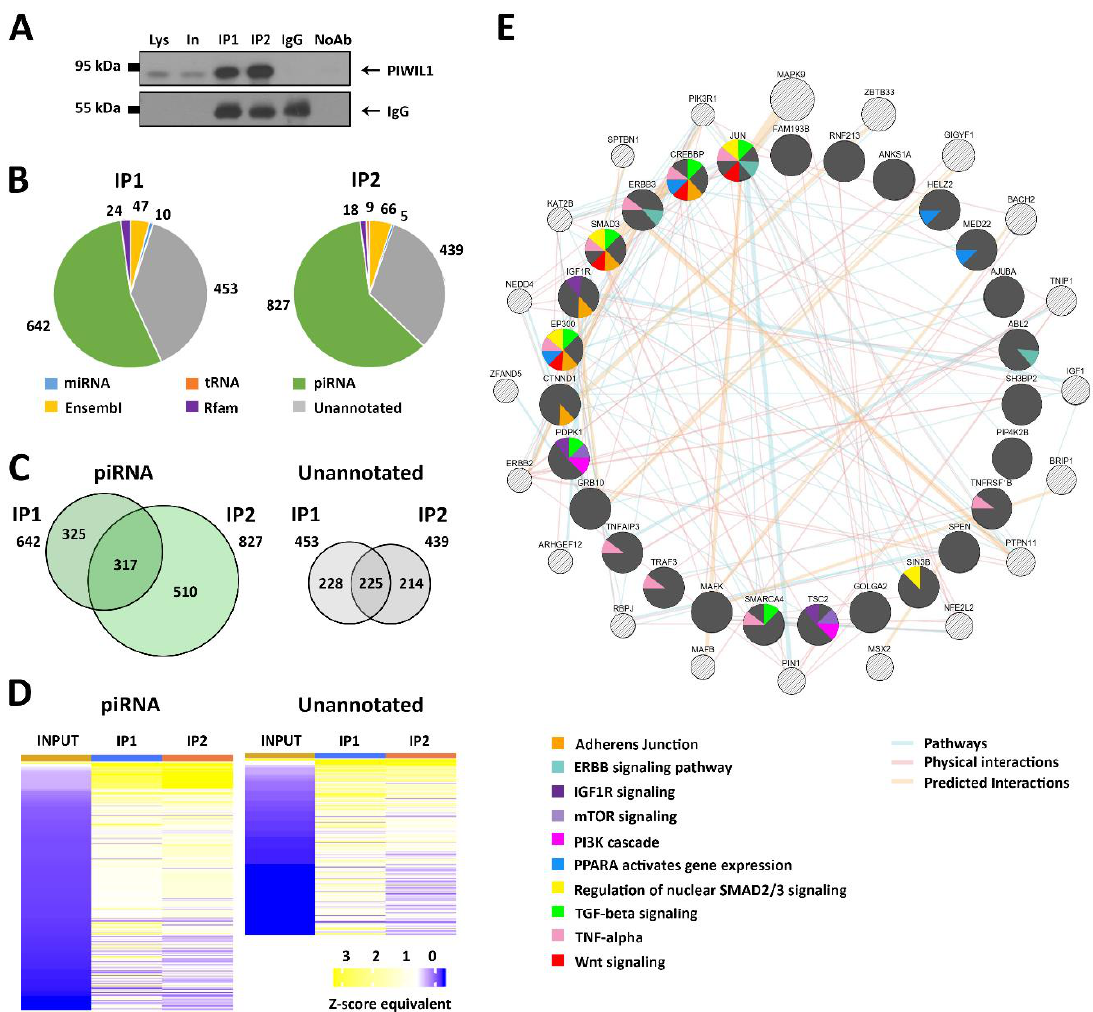
Figure 4. Identification of PIWIL1-bound RNAs. ( A ) RNA immunoprecipitation (RIP) was performed in the cytosolic fraction of COLO 205 cells with two different antibodies (IP1 and IP2); the presence of PIWIL1 protein was assessed by western blotting in the cytosolic lysate (Lys), Input (In), IP1, and IP2; PIWIL1 was absent in negative controls (IgG and NoAb); IgG were used as a control for IP loading. ( B ) Pie chart representing the number of enriched molecules per category in both IP1 and IP2 samples; ( C ) Venn diagram summarizing the number of piRNAs (left) and unannotated molecules (right) identified with both antibodies; ( D ) heatmaps representing Z-score expression values for 317 piRNAs (on the left) and 225 unannotated RNAs (on the right) identified in PIWIL1 RIP-Seq with two different antibodies (IP1 and IP2), compared to the input RNA. ( E ) Network analysis and functional enrichment for 106 validated interactions revealed a group of 27 master-regulator genes targeted by the PIWIL1–piRNA complex and 20 correlated genes strongly related with molecular pathways crucial for CRC pathogenesis. Relations between genes (173 links, Table S9E) and association to pathways are represented with a color code. Abbreviations: ERBB, avian erythroblastosis oncogene B; IGF1R, insulin like growth factor 1 receptor; mTOR, mechanistic target of rapamycin kinase; PI3K, phosphoinositide 3-kinase; PPARA, peroxisome proliferator activated receptor alpha; SMAD2/3, mothers against decapentaplegic homolog 2/3; TGF, transforming growth factor; TNF, tumor necrosis factor; Wnt, wingless/int-1.